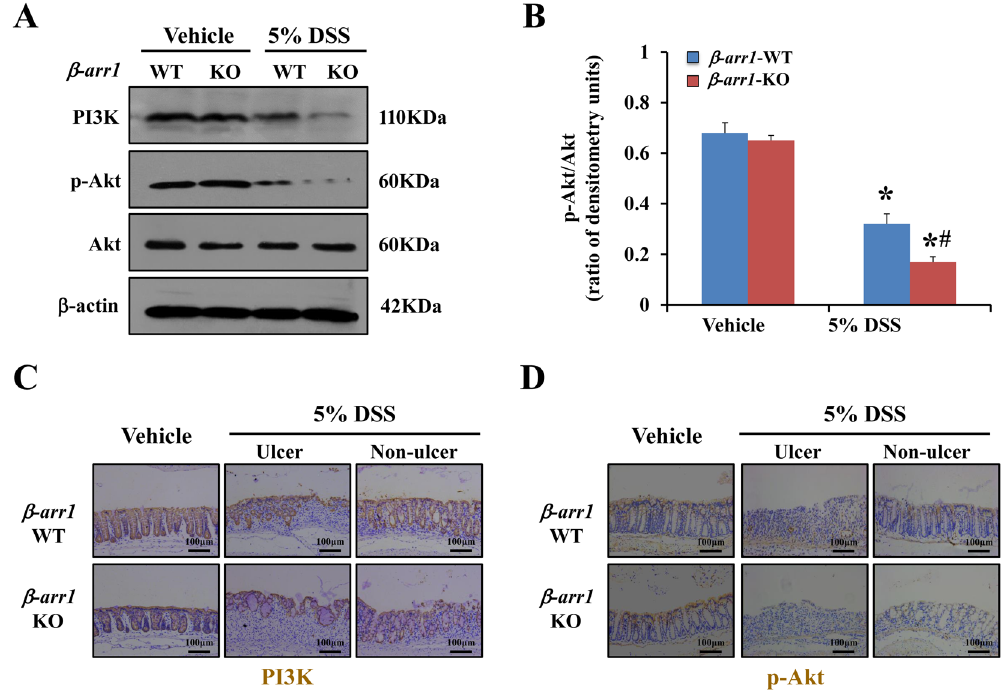
Figure 5. β -arr1 actives PI3K/Akt signaling in colitis. ( A ) Western blot of PI3K, p-Akt and Akt in colonic mucosa of β -arr1 WT and KO mice with or without DSS treatment at the indicated time points. All western blot images are representative images from five independent experiments, and β -actin was used as a loading control. ( B ) Quantitative analysis of p-Akt/Akt as measured by densitometry scanning of Western blots. Values are expressed as the mean ± SD of five independent experiments, * P < 0.05 versus vehicle group, # P < 0.05 versus β - arr1 KO mice after 5% DSS treatment. ( C ) Immunohistochemical staining for PI3K in colonic sections of β -arr1 WT and KO mice in the control group, and the ulcer section and non-ulcer section in the DSS group (brown, × 200, n = 4 per group). ( D ) Immunohistochemical staining for p-Akt in colonic sections of β -arr1 WT and KO mice in the control group, and the ulcer section and non-ulcer section in the DSS group (brown, × 200, n = 4 per